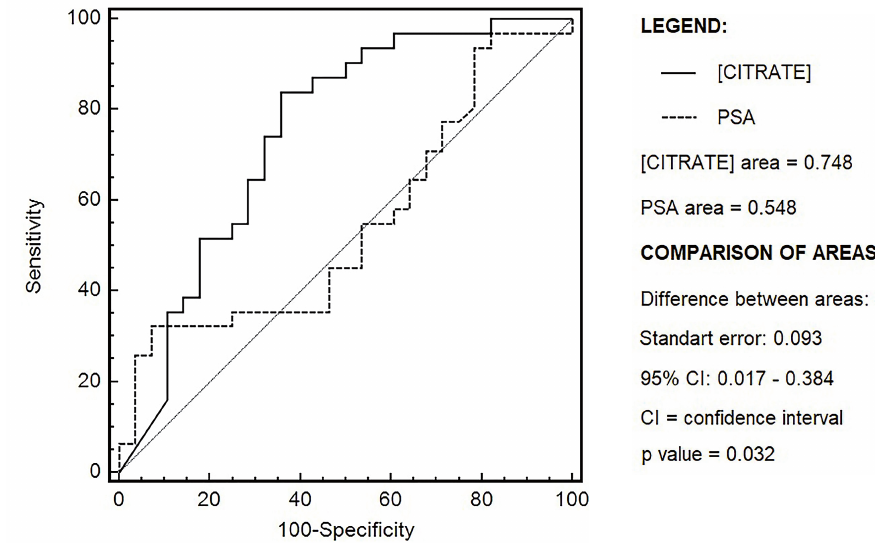
Figure 2 - ROC curves corresponding to variables [CITRATE] and PSA and comparison of the areas under the